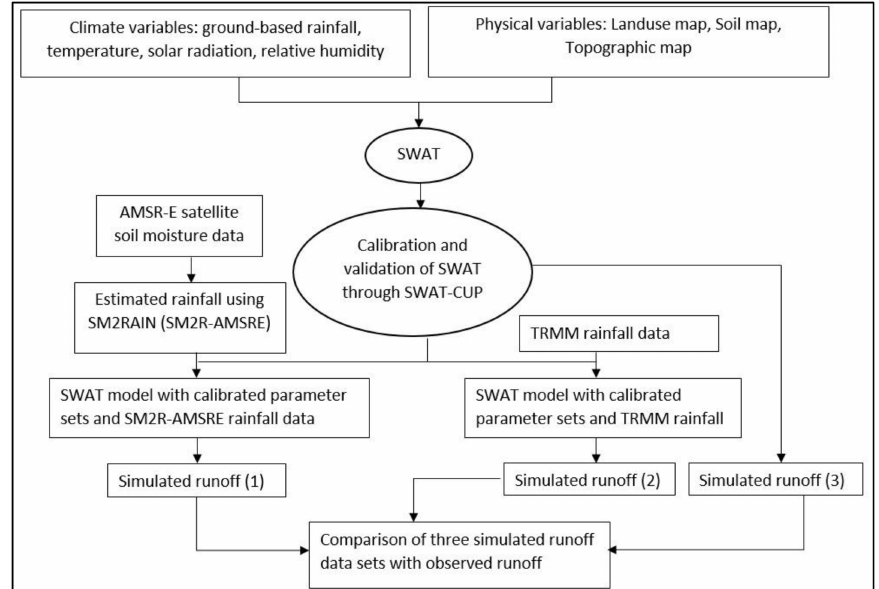
Figure 2. Flowchart for the evaluation of simulated runoff through Soil Water Assessment Tool (SWAT) using both ground-ased and SM2R-AMSRE precipitation as input data.